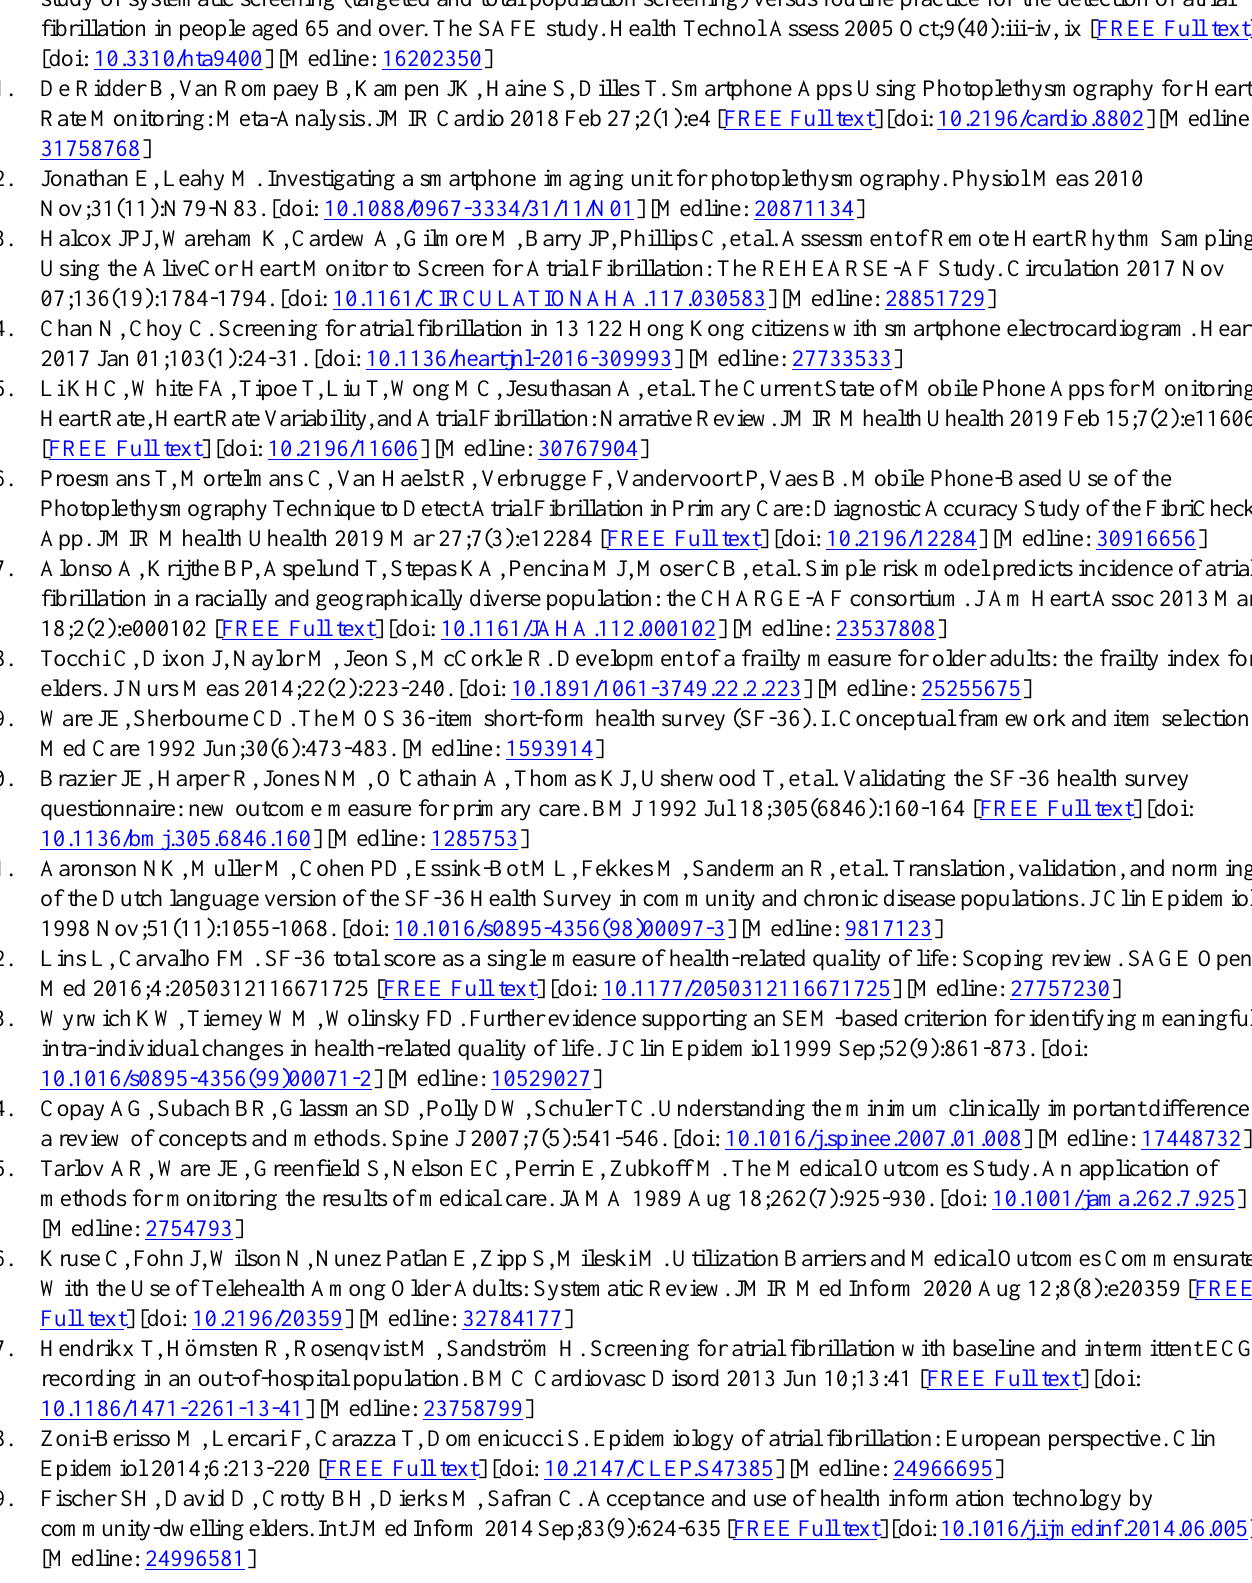
AF: atrial fibrillation ECG: